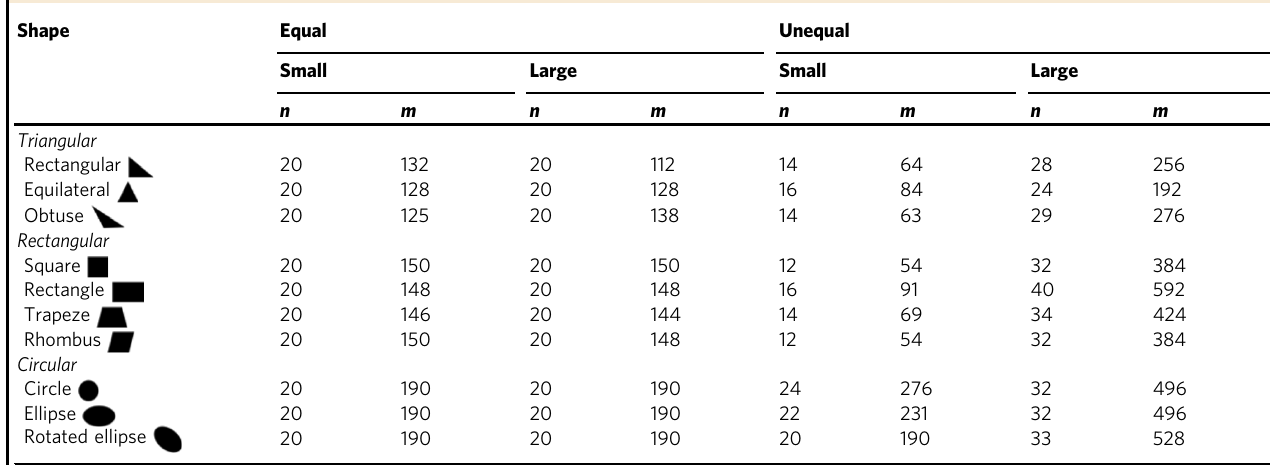
Table 1 Properties of the visibility graphs of the synthetic set with equal and unequal number of